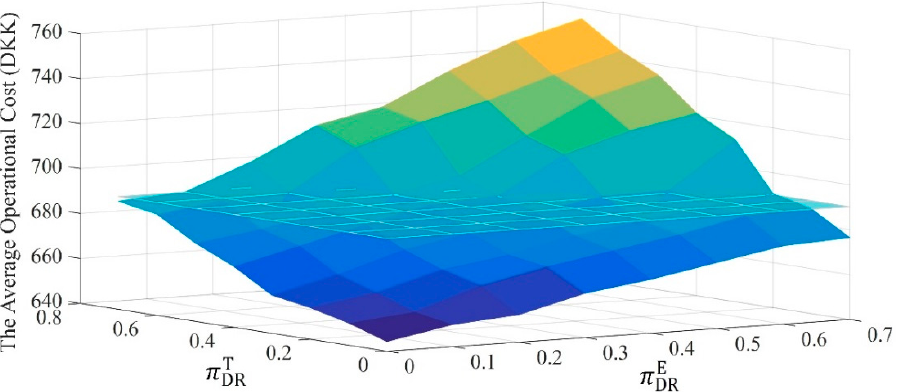
Figure 12. A surface of CCHP micro-grid’s obtained AOC s with changes in π (cid:2888)(cid:2902)(cid:2889) and π (cid:2888)(cid:2902)(cid:2904) .